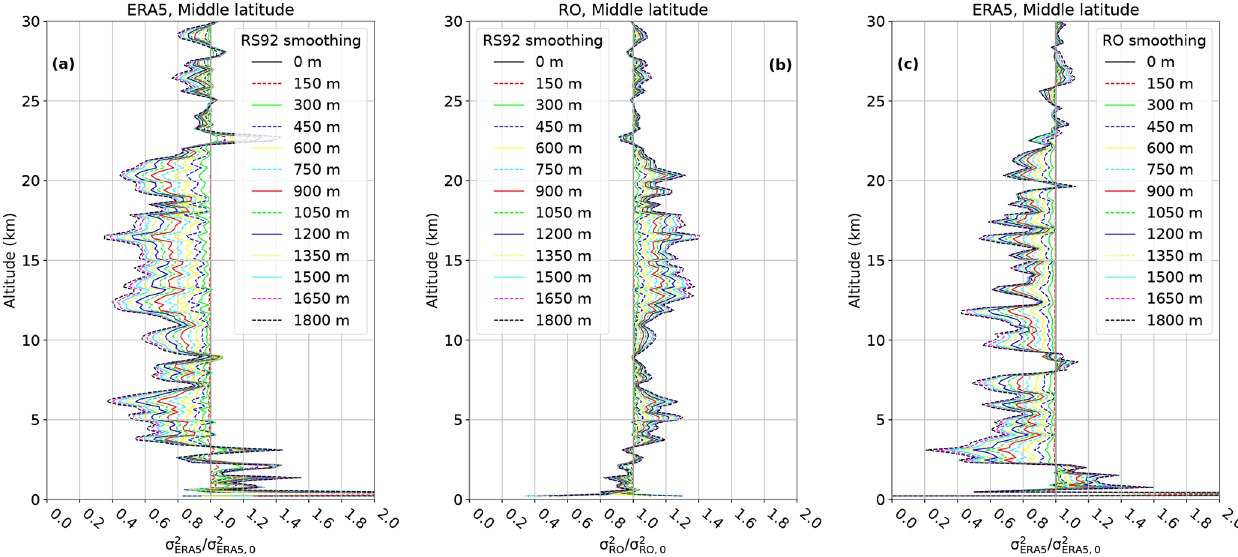
Figure 9. Estimates of middle-latitude refractivity error variances based on smoothed data divided by refractivity error variance based on un-smoothed data; (a) ERA5 error variance with smoothed RS92, (b) RO error variance with smoothed RS92, and (c) ERA5 error variance with smoothed RO. The legends show the width of the different vertical Gaussian filters applied to the refractivity profiles mentioned in the legend title; e.g. σ ERA5 /σ ERA5 , 0 in panel (a) means uncertainty estimate of ERA5, given filtering of the data set mentioned in the legend – in this case RS92, divided by the uncertainty estimate of ERA5, obtained without filtering. A total of 9722 collocated data triplets were used in the G3CH analysis for these error covariance estimates.